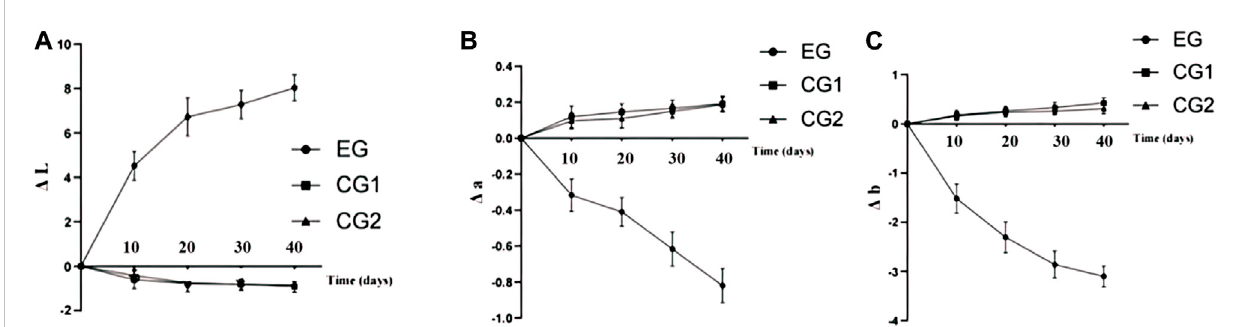
FIGURE 4 Thechangein Δ L, Δ aand Δ bduringbleachingfor40days. (A) Thechangein Δ L. (B) Thechangein Δ a. (C) Thechangein Δ b.EGreferstoExperimental group. CG1refers to Conditional control group. CG2refers to Blank control group.